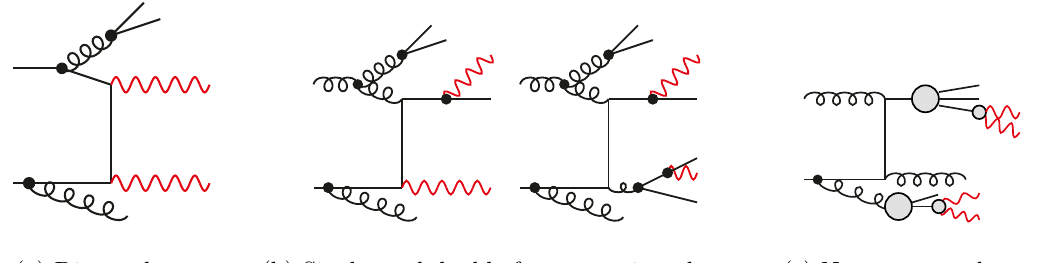
Figure 1. Schematics of theoretical photon pair production mechanisms (a, b) and an example of experimental background (c) from non-prompt multiphoton production. Quarks are represented by straight lines, gluons by curly lines, and photons by red wavy lines. The black dots represent resummed bremsstrahlung, e.g. from a fragmentation function or parton shower, while the grey circles represent hadronisation and hadron decay processes. The presence of jets is not required in the following and only included for illustration